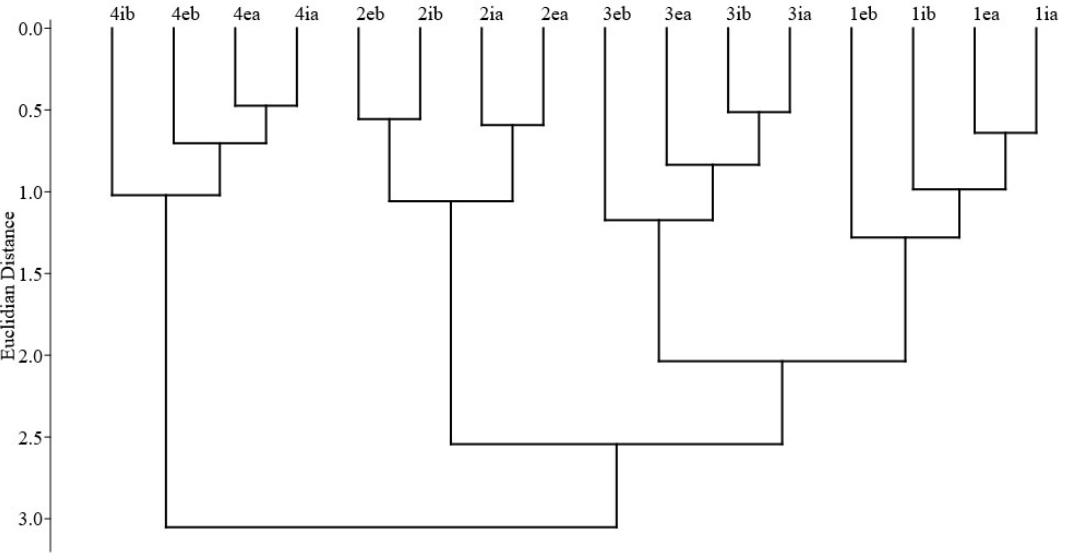
Figure 6. The similarity of the beetle species composition among all sampling variants (four sites, two height levels, and two positions regarding the proximity of the forest edge) based on the Jaccard index. We applied Ward’s method and the Euclidean distance (cophenetic correlation coefficient = 0.771). 1—plot1; 2—plot2; 3—plot3; 4—plot4; “i”—forest interior; “e”—edge of the forest; “a”—at the top height (7.5 m), “b”—at the lowest height (1.5 m).